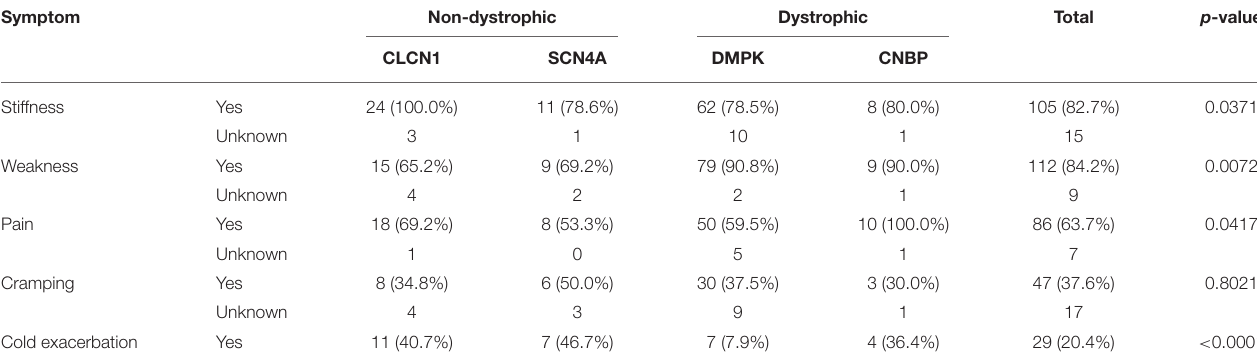
TABLE 5 | Summary of patient reported symptoms by genotype. Symptom